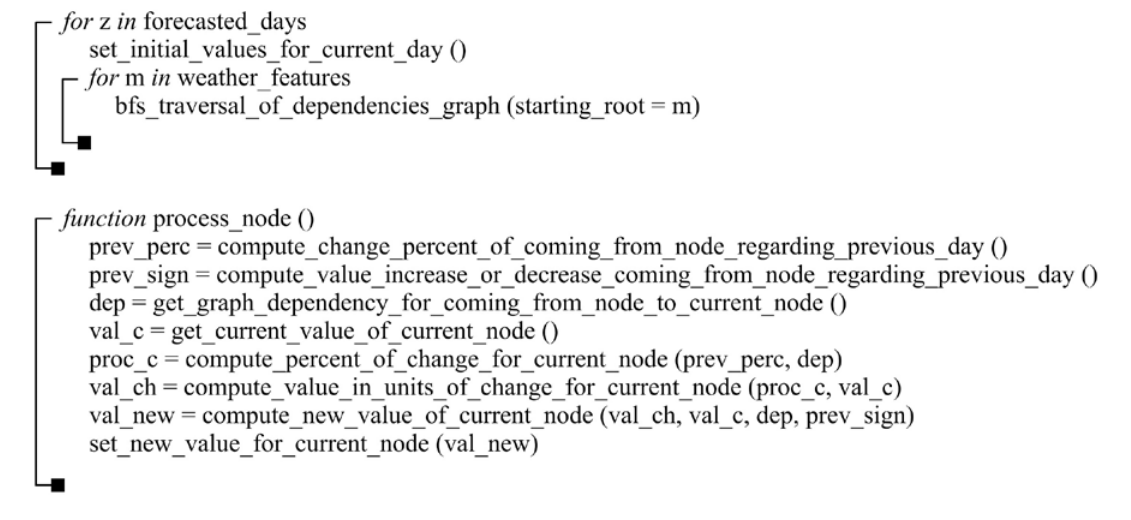
Figure 3. Summarized overview of the implemented prediction algorithm .